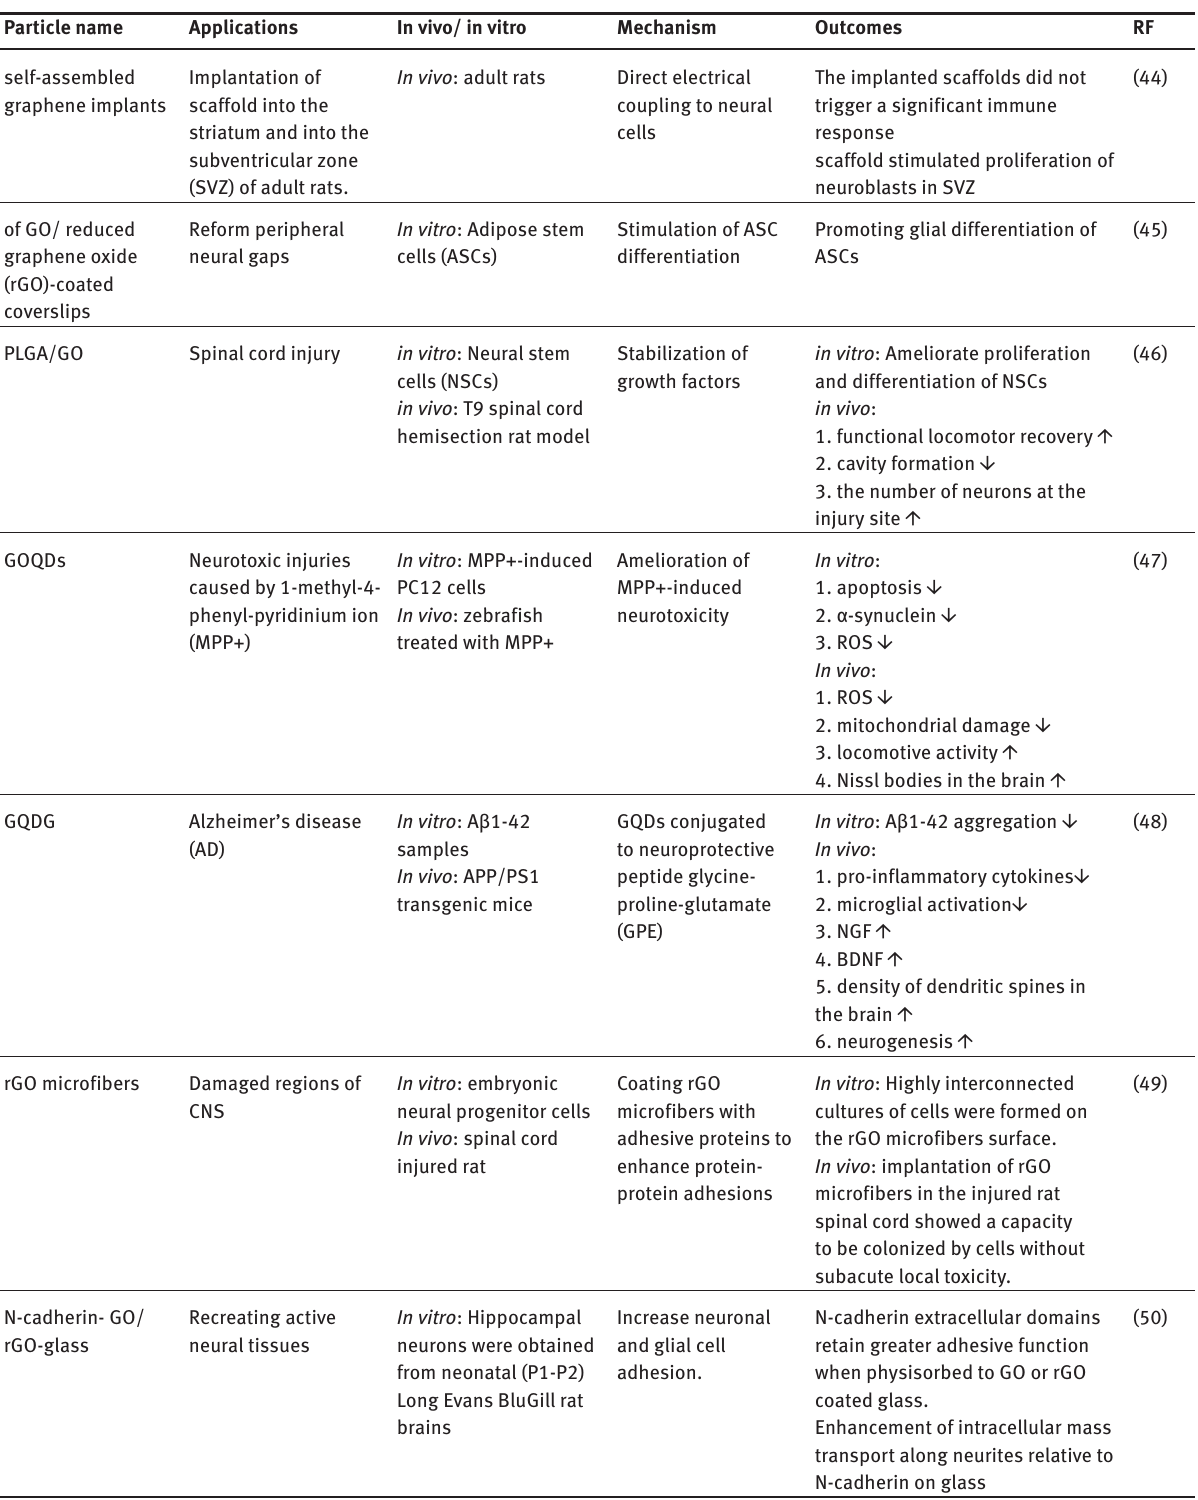
Table 1: Applications of graphene oxide (GO) derivatives in nerve regeneration. Particle